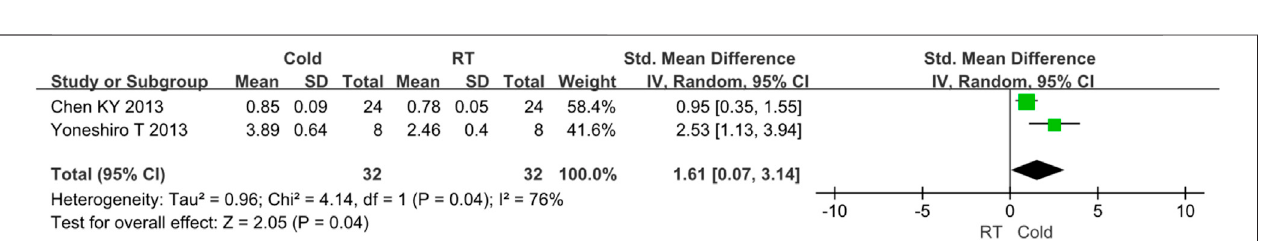
FIGURE 5 | Forest plot for the effect of cold temperature on human brown adipose tissue activity.